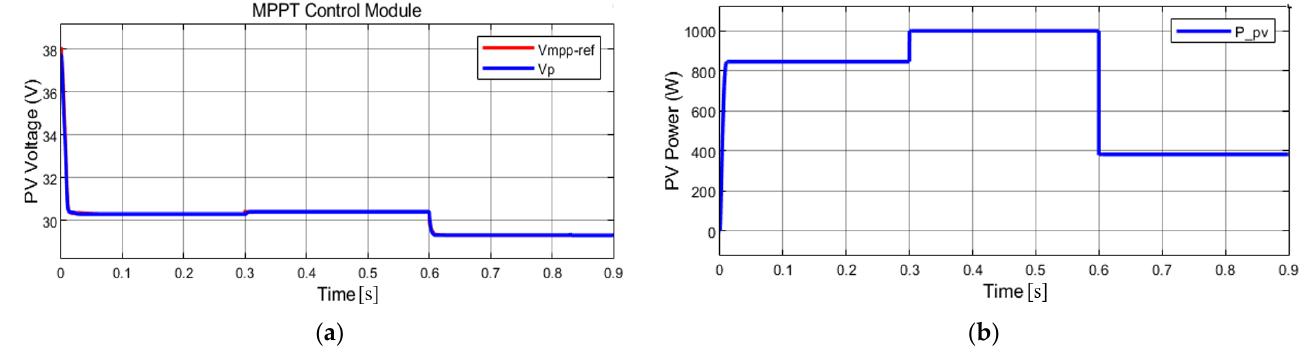
Figure 10. MPPT module performance for constant temperature: ( a ) PV voltage; ( b ) PV output power.